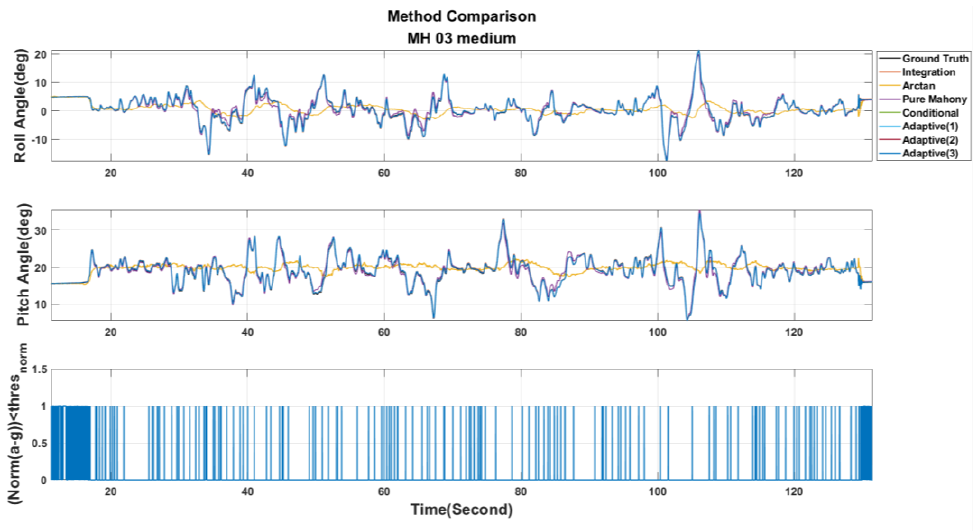
Figure 12. Roll and pitch angles were obtained from different adjustment strategies for the MH_03_medium series.